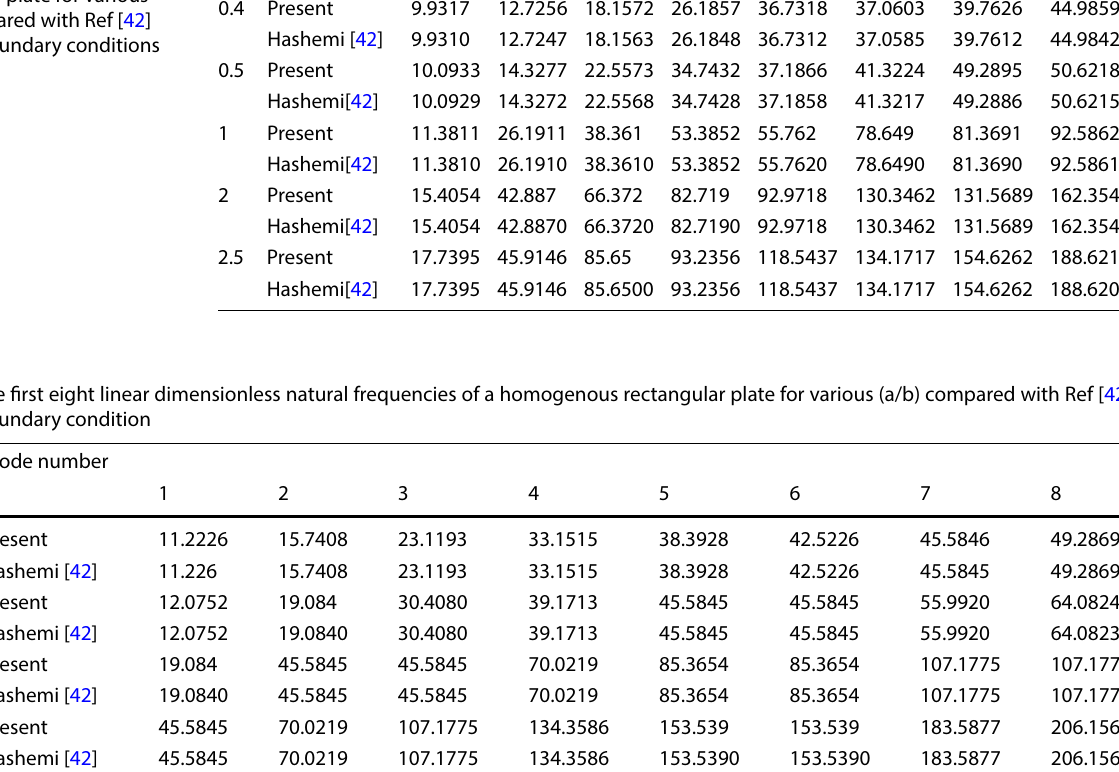
Table 1 The first eight linear dimensionless natural frequencies of a homogenous rectangular plate for various (a/b) compared with Ref [42] for SSSF boundary conditions